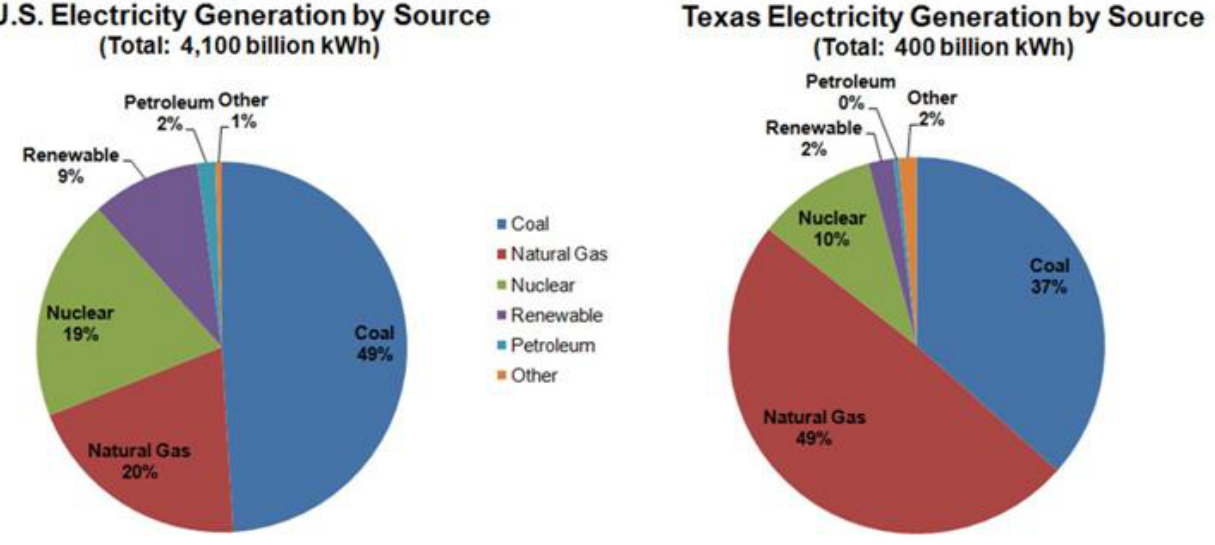
Fig. 2 . United States (left) and Texas (right) electricity generation, in percent, by primary energy source for 2006 (Energy Information Administration 2008, Energy Information Administration 2009b). While nearly half of the electricity generated nationwide is from coal, nearly half of the electricity generated in Texas is from natural gas. Here, renewable includes traditional hydro power, solar, and wind